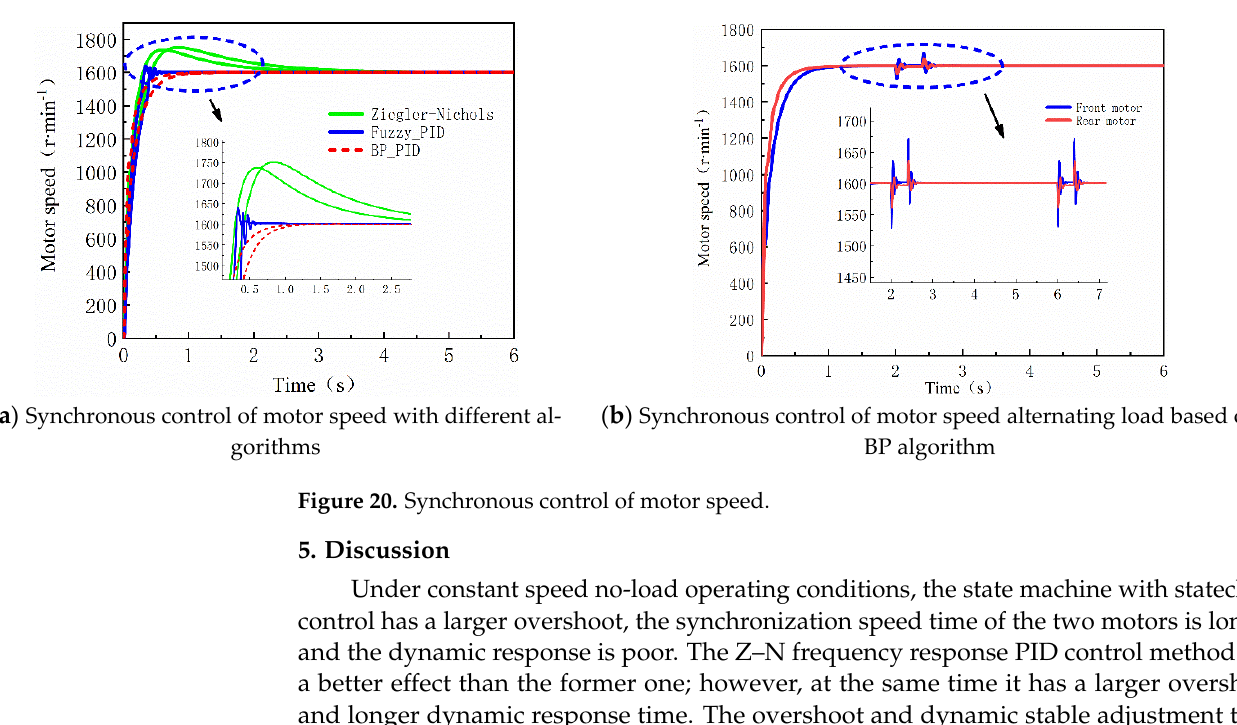
Table 2. Comparison of parameters of different control methods .